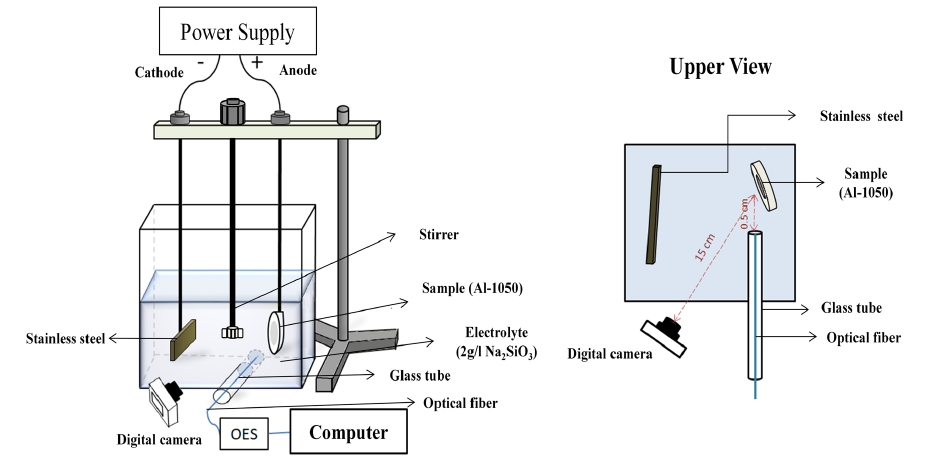
Figure 1. Schematic diagram of the experimental